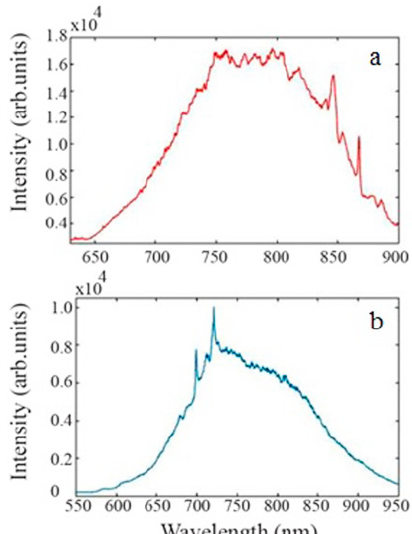
Figure 5. Photoluminescence spectra under 532 nm excitation of ( a ) commercial and ( b ) ball-milled and MgO nanoparticles.